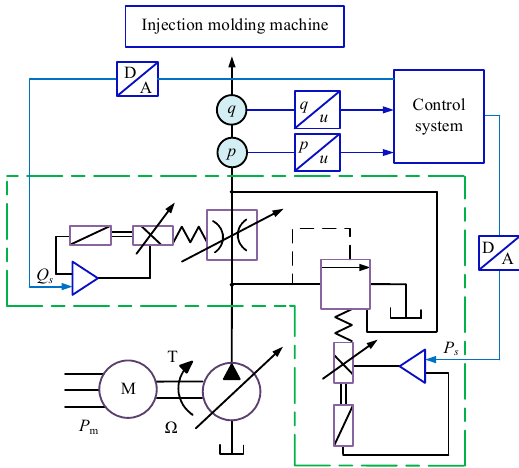
Figure 4. The structure diagram of a fixed displacement pump drive system.